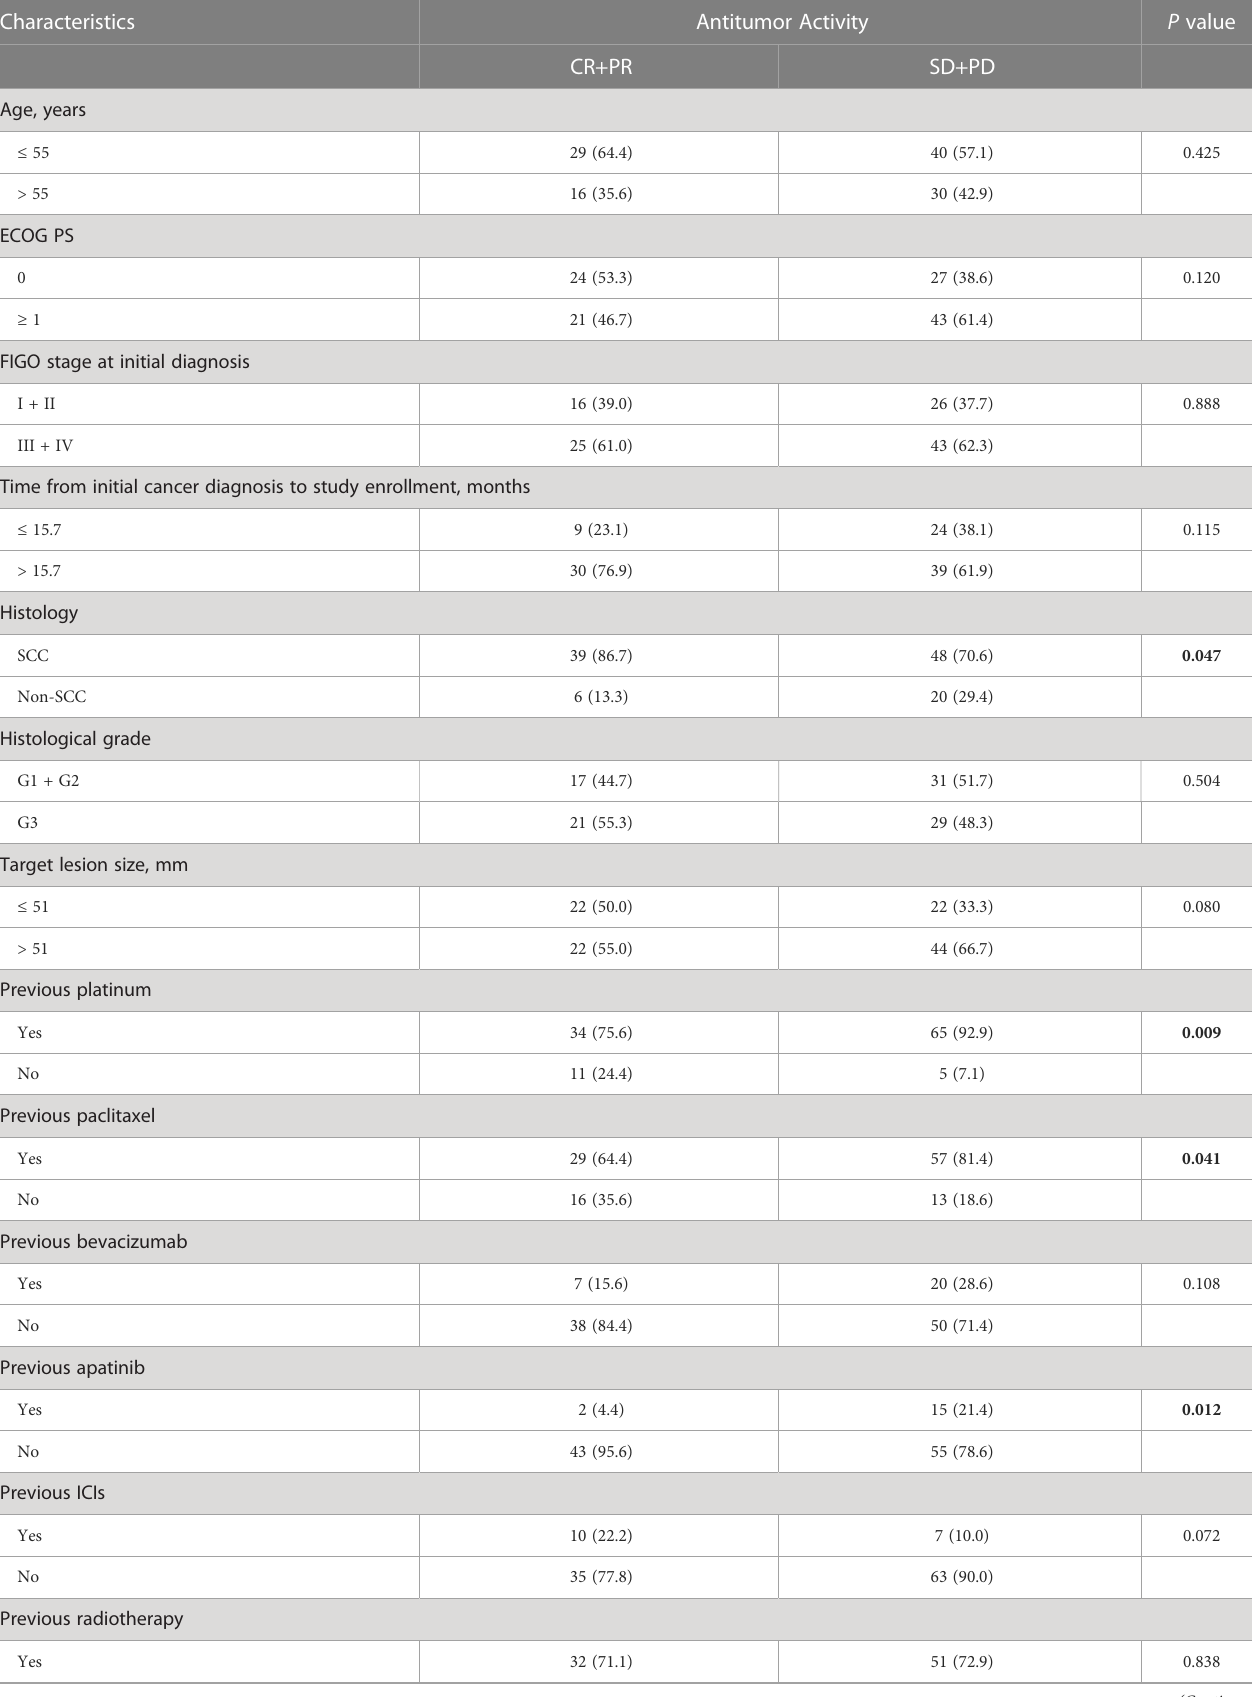
TABLE 4 Correlation between the antitumor response and clinicopathological factors in patients treated with tislelizumab.